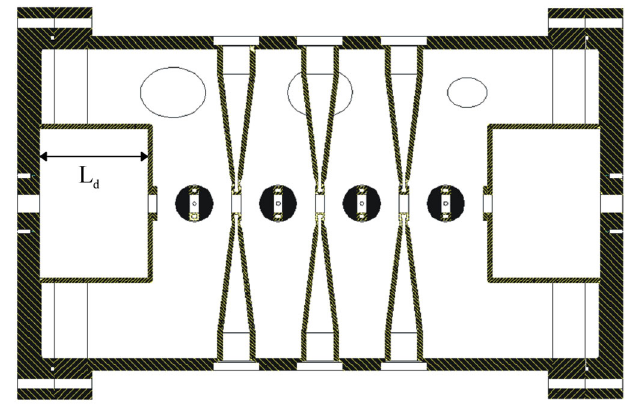
FIG. 15. The influence of the last half drift tube length in Fig. 16) on the field distribution on the cavity ( L d